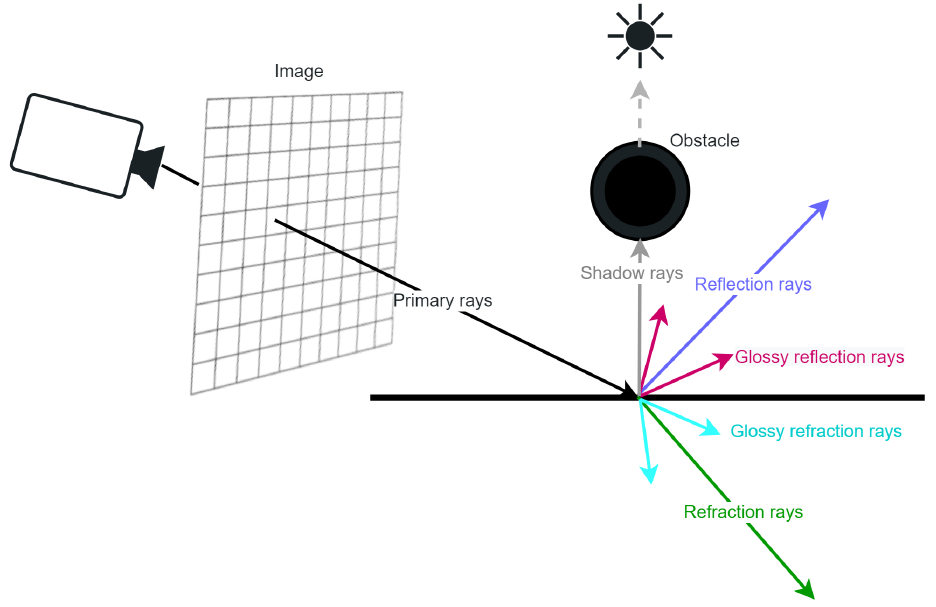
Figure 2. The basic mechanism of RTg.